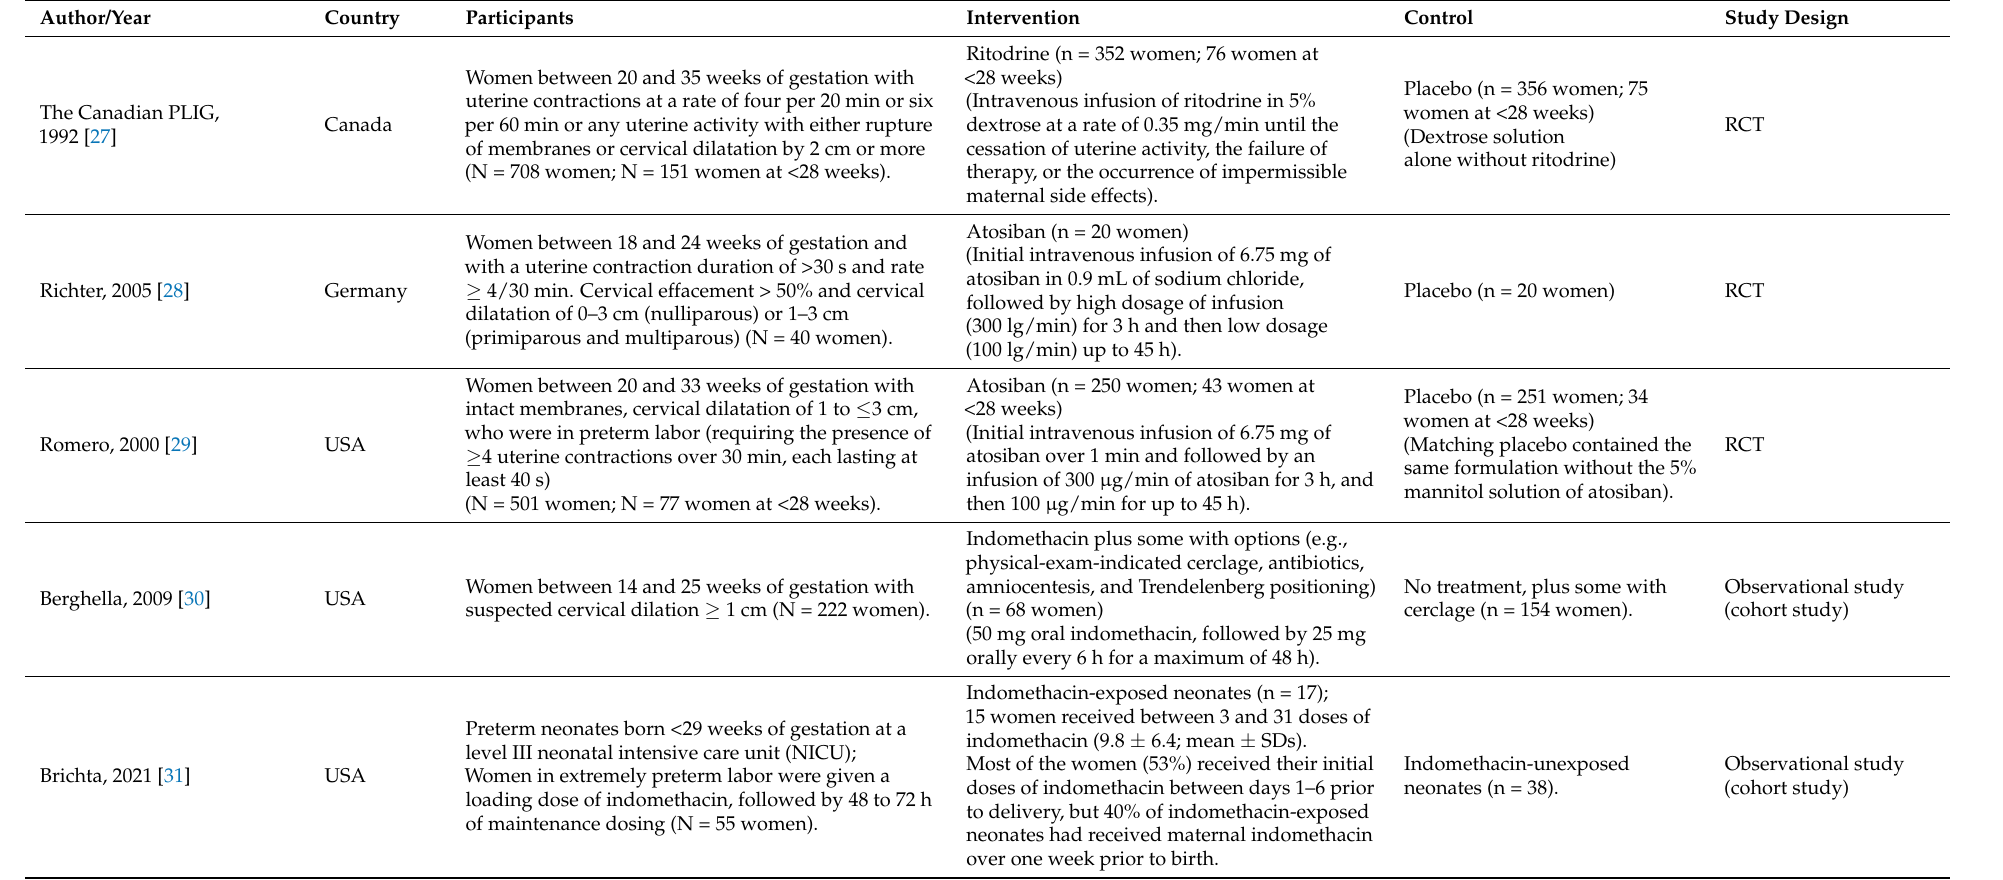
Table 1. Characteristics of included studies for CQ1: women experiencing extremely preterm birth (<28 weeks of